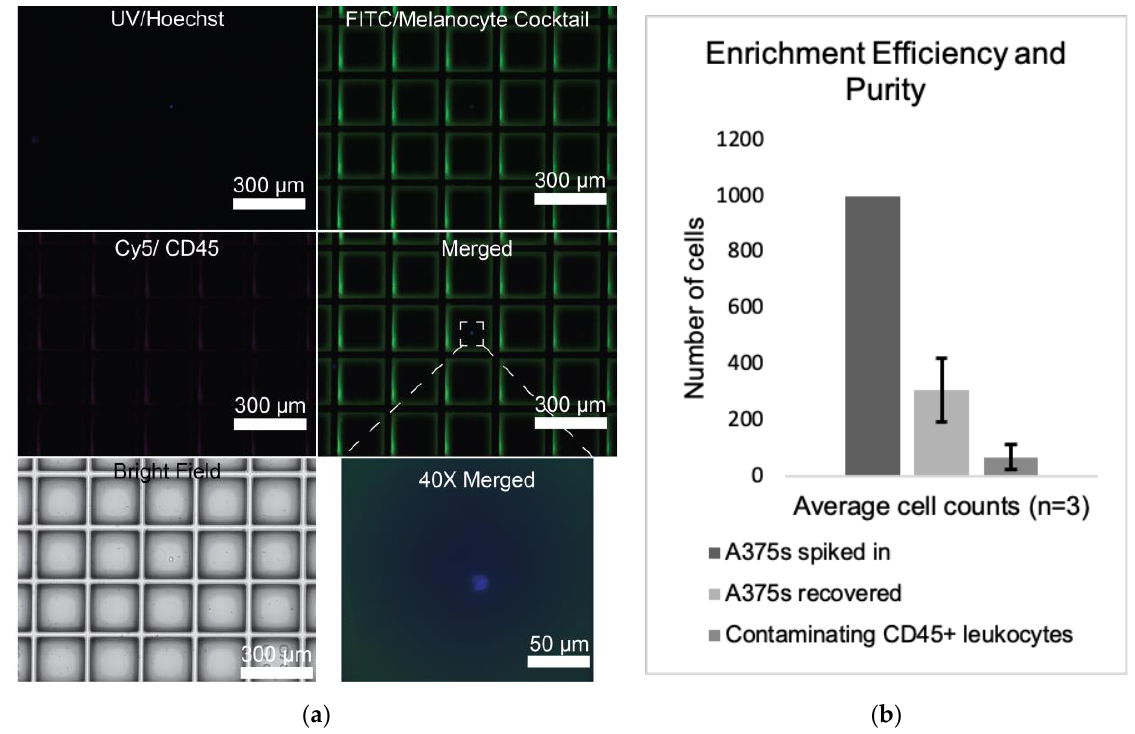
Figure 3. Recovery Efficiency and Purity of Melanoma Cell Enrichment: ( a ) The StemCell technol- ogies EasySep Direct Human CTC Enrichment Kit combined with an antibody cocktail stain